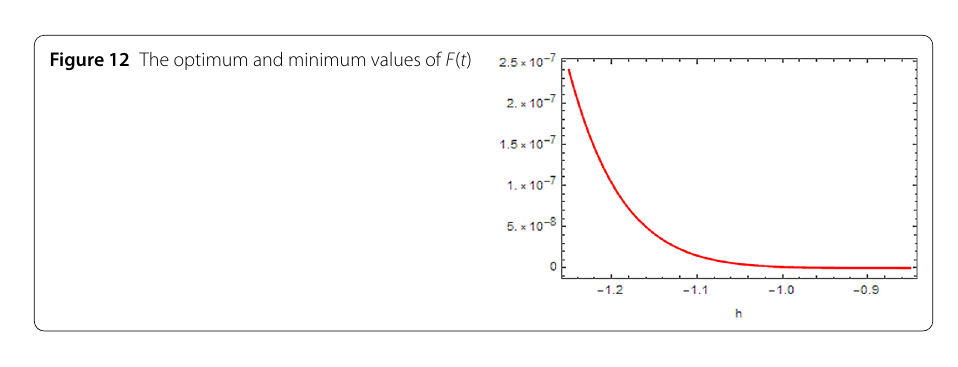
Figure 13 The optimum and minimum values of G ( t )